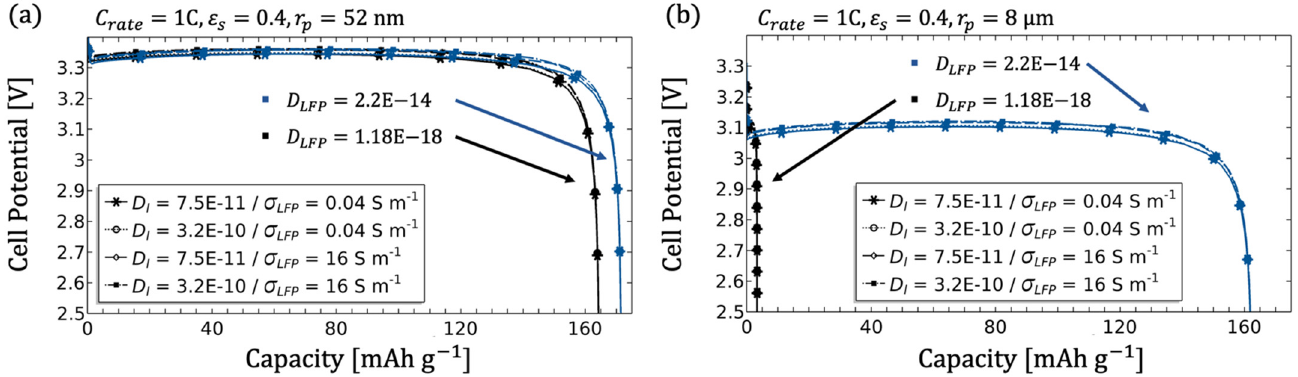
Figure 11. Discharge performance of a thin 50 µ m electrode at 1C, ε s = 0.4, σ LFP = 0.04 S m − 1 and σ LFP = 16 S m − 1 as well as peak electrolyte diffusivity of D l = 7.5 × 10 − 11 m 2 s − 1 and D l = 3.2 × 10 − 10 m 2 s − 1 at 1 M. In ( a ) the particle size is r p = 52 nm and in ( b ) r p = 8 µ m. The black curve represents a diffusion coefficient of 1.18 × 10 − 18 , and the blue curve stands for a diffusion coefficient of 2.2 × 10 − 14 .